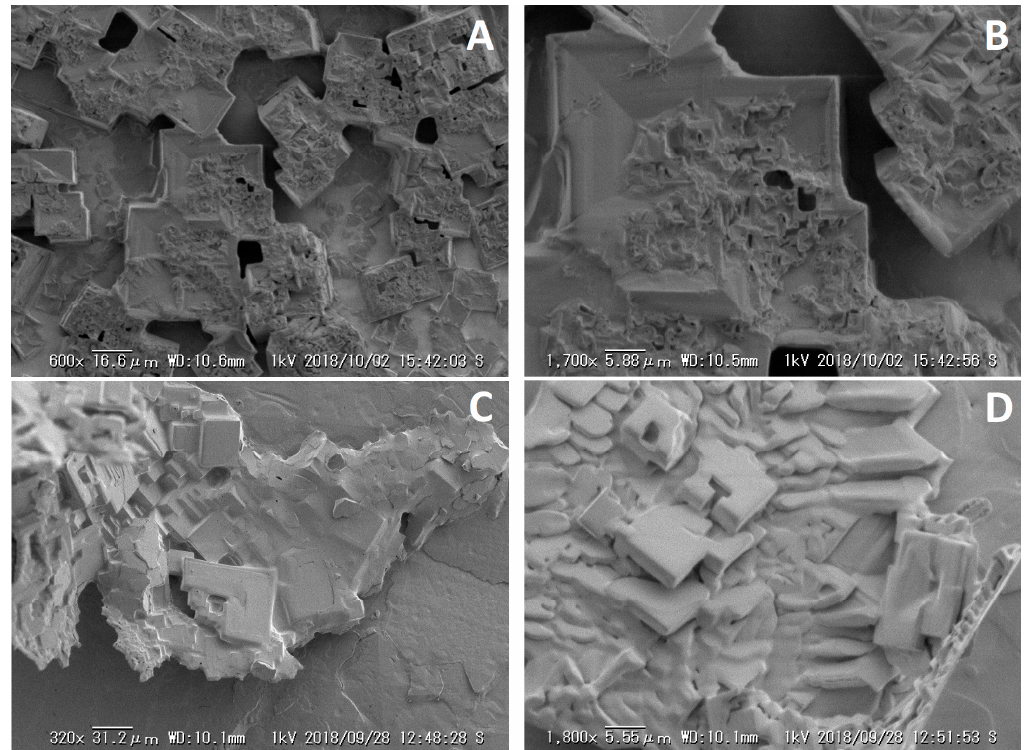
Figure 5. Scanning electron microscopy (SEM) micrographs of pure KCl ( A , B ) and L1 in 3 M KCl ( C , D ).